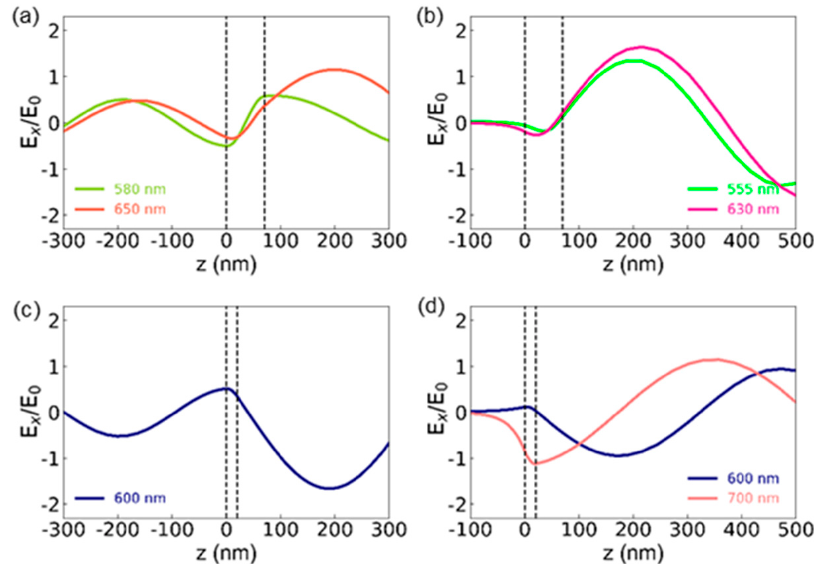
Figure 4. FDTD-calculated E-field distributions of 70-nm-thick WS 2 flakes on ( a ) SiO 2 /Si and ( b ) Au and 20-nm-thick WS 2 flakes on ( c ) SiO 2 /Si and ( d ) Au. The wavelengths correspond to the local minima of the reflectance spectra (Figure 2b,c). The regions between two dashed lines represent the WS 2 flakes. The left and right sides of the dashed lines correspond to the underlying layers (SiO 2 and Au) and air, respectively. The z-axis is perpendicular to the sample surface and the origin is set at the WS 2 /substrate interface. E 0 indicates the magnitude of the E-field of the incident light. The d WS2 of 20 nm is only ~1/10 of the wavelength of visible light, even if the large